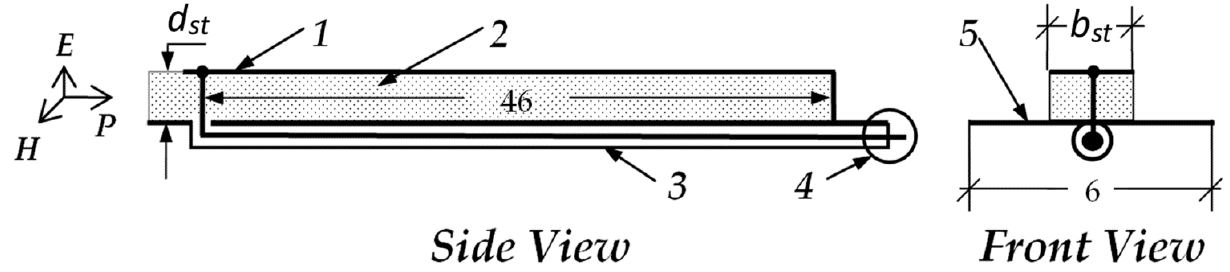
Figure 7. E -Dot scheme. 1 = signal electrode; 2 = dielectric slat; 3 = HF cable to digital recorder; 4 = coaxial connector; 5 = base plate.